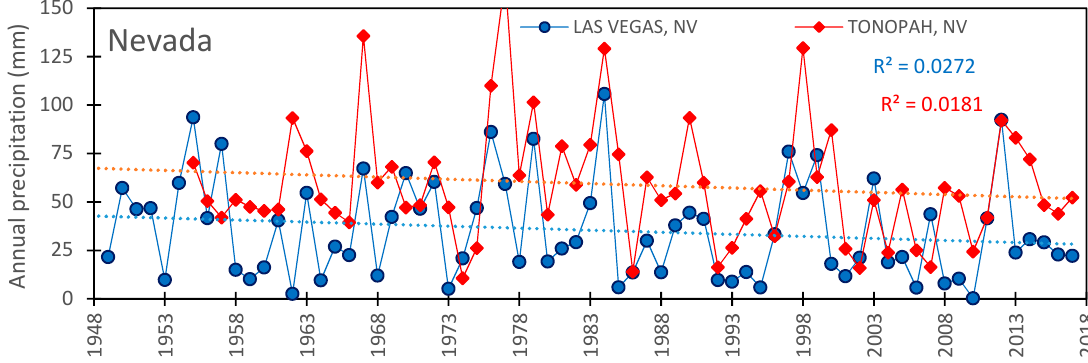
Figure 3. Temporal trend in crop growing season precipitation in the states of Texas, New Mexico, Colorado, Arizona, Utah, Nevada, and California.